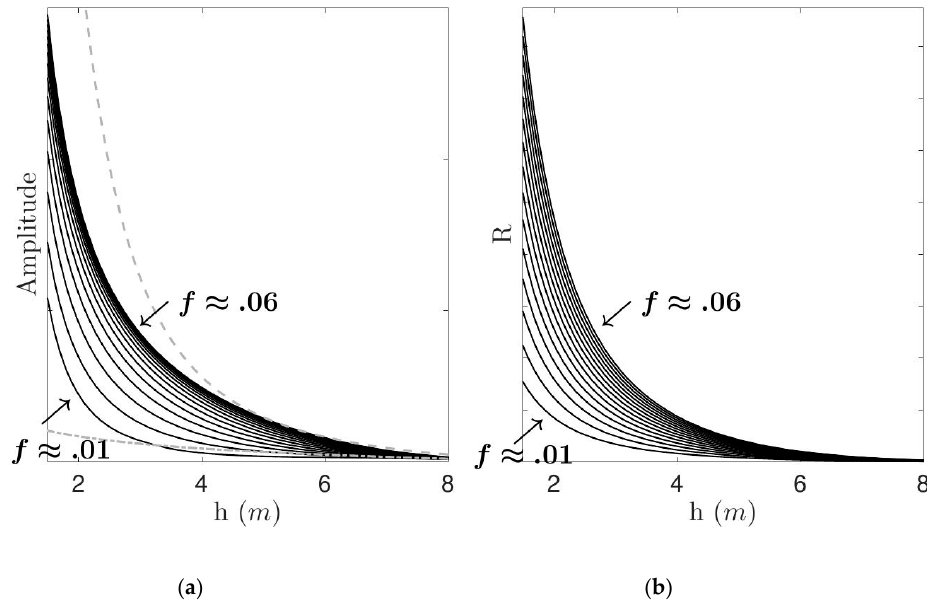
Figure 5. ( a ) Amplitude variation of total infragravity wave during shoaling for di ff erent group − 5/2 − 1/4 frequencies, grey dashed line ( ∼ h ), grey dash-dotted line ( ∼ h ). ( b ) Variation in theoretical rates of energy transfer calculated based on the observed lags using Equation (7) for di ff erent group frequencies.